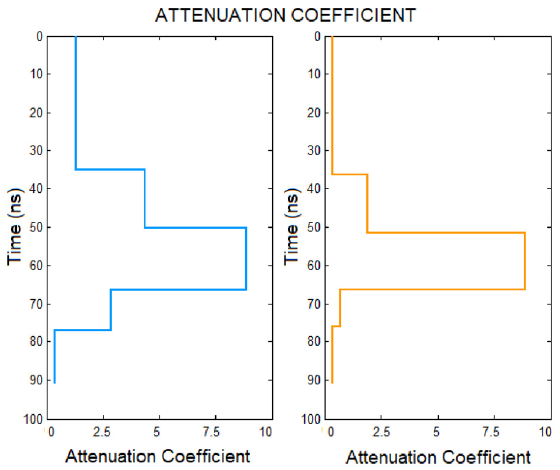
Figure 11. Representation of the attenuation coefficient as a function of time in two example traces.